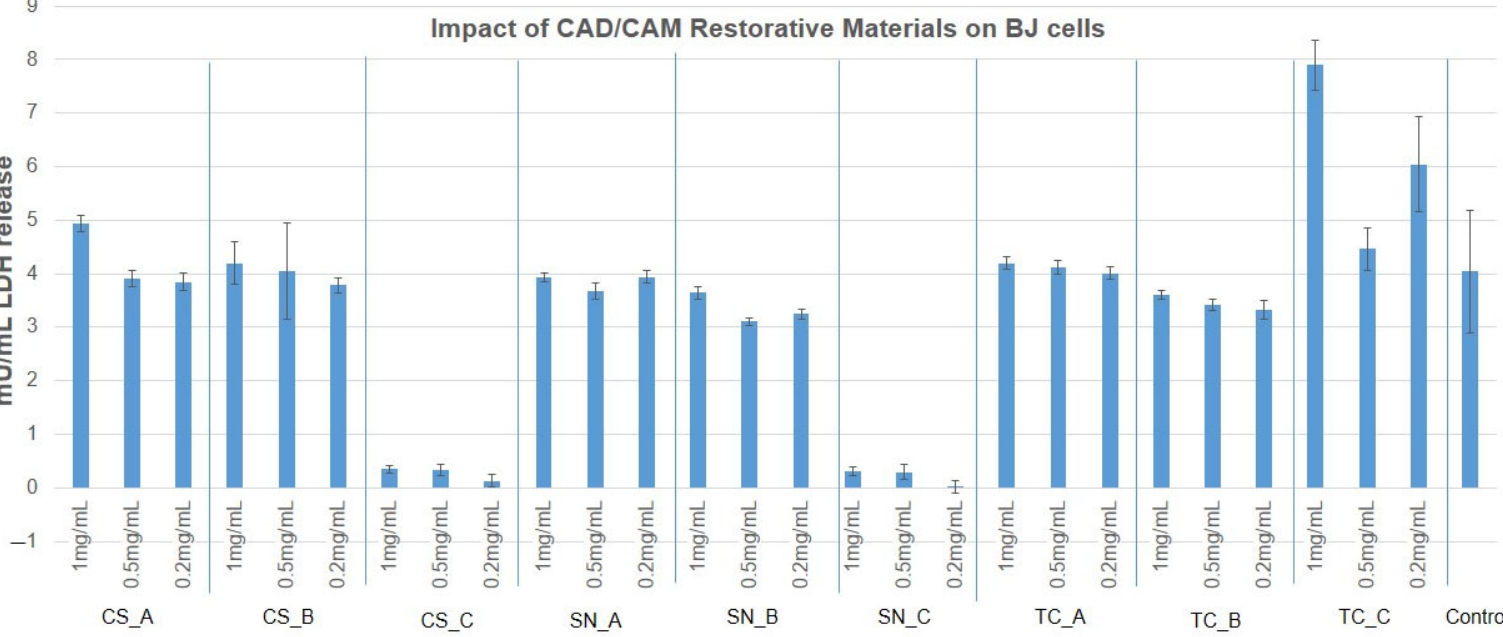
Figure 8. Cytotoxicity percentage of BJ cells, after treatment with nonexposed/exposed to acidic artificial saliva of CAD/CAM restorative materials powders, at three different concentrations (1 mg/mL, 0.5 mg/mL and 0.2 mg/mL), for an interval of 24 h.